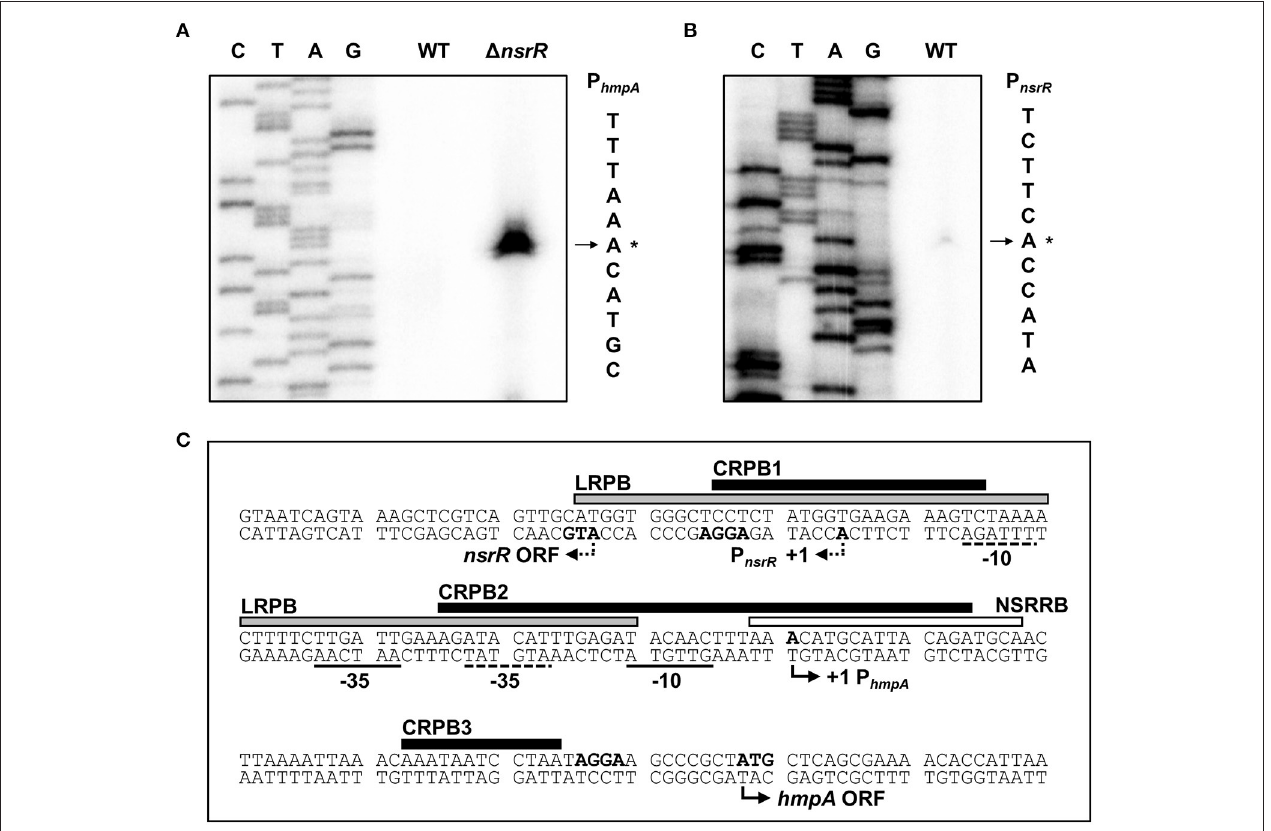
FIGURE 4 | Sequence analysis of the nsrR - hmpA regulatory region. (A,B) The TSSs of hmpA (A) and nsrR (B) were determined by the primer extension of RNA isolated from the wild-type and 1 nsrR strains grown aerobically to an A 600 of 0.5. Lanes C, T, A, and G represent the nucleotide sequencing ladders. The asterisks indicate the TSSs. WT, wild type; 1 nsrR , nsrR -deletion mutant. (C) Double-stranded DNA sequence of the nsrR - hmpA regulatory region is shown. The TSS and putative translation start codon of nsrR are indicated by dashed bent arrows, and those of hmpA are indicated by solid bent arrows. The putative − 10 and − 35 regions are underlined with dashed lines for P nsrR and solid lines for P hmpA . The putative ribosome-binding sites (AGGA) are boldface. The binding sequences of NsrR (NSRRB; a white box), Lrp (LRPB; a gray box), and CRP (CRPB1, CRPB2, CRPB3; black boxes) were determined in the later parts of this